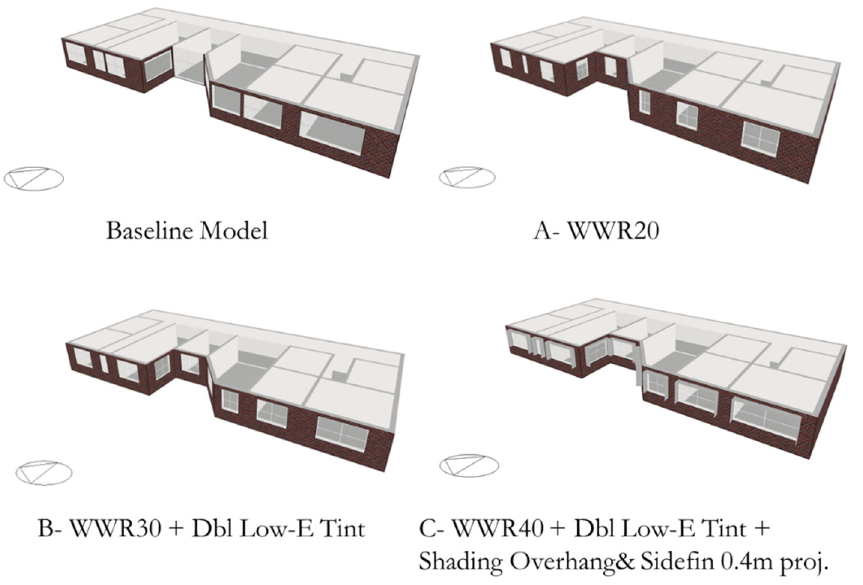
Figure 12. Illustrations of the highest-performing evidence-based design options for the west façade energy optimization.